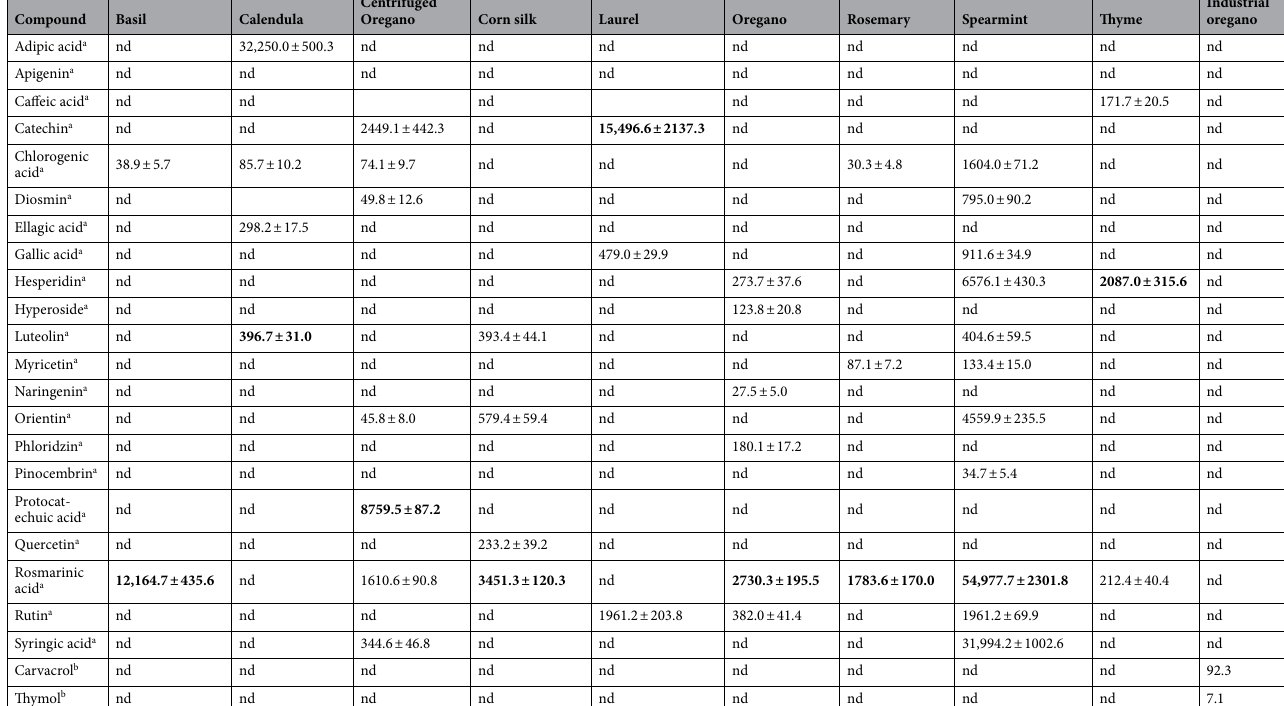
Table 1. Composition of hydro-and steam-distilled aqueous extracts based on UPLC-HESI-MS/MS and HPLC–DAD analyses, respectively. The main compound of each extract is indicated in bold. nd: not detected. a ng/g. b